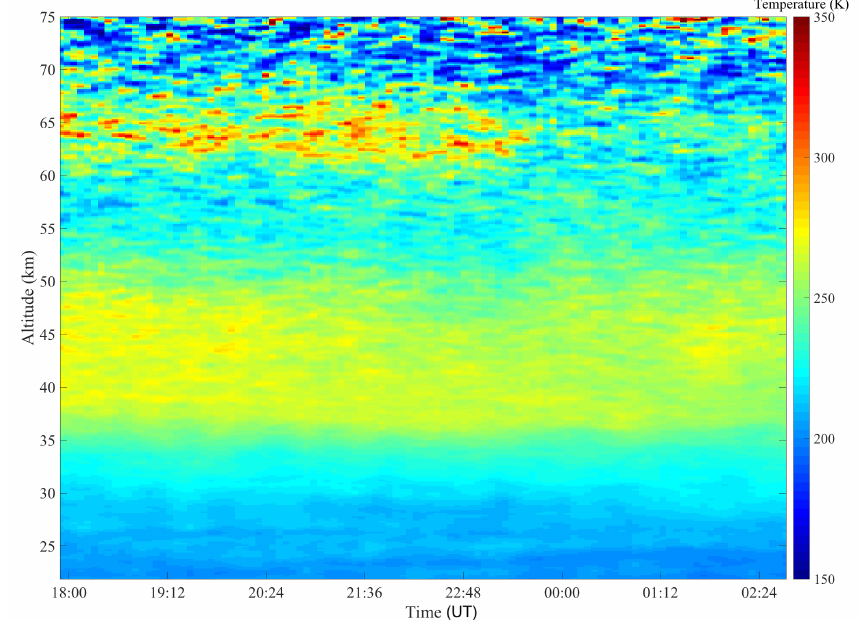
Figure 1. The 2D temperature profile measured by the OHP Rayleigh lidar during the night of 12–13 December